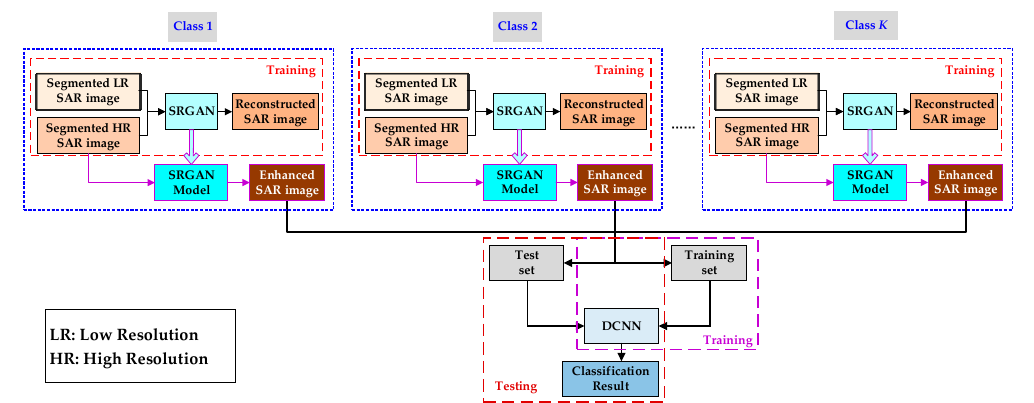
Figure 5. The flow chart of ATR for SAR image based on SRGAN and DCNN.